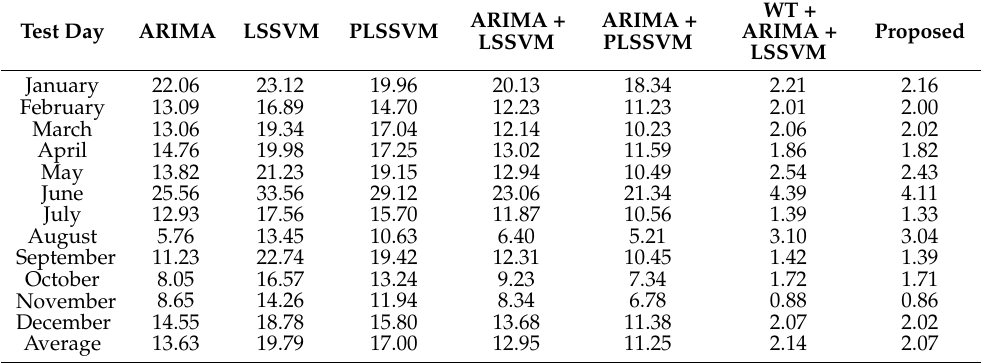
Table 4. Comparison of the methods based on the support vector network to forecast the Australian electricity market.